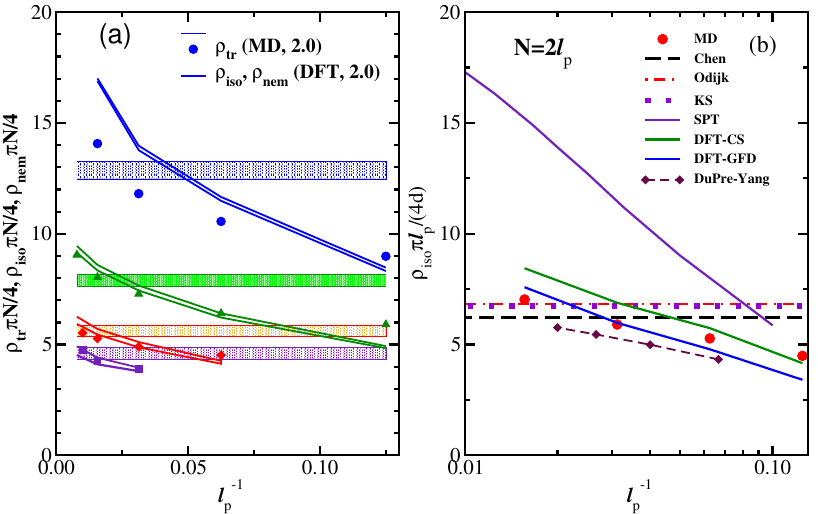
Figure 3. ( a ) Transition densities scaled as ρ i π N /4, ρ n π N /4 and ρ tr π N /4 plotted vs. d / (cid:96) p (using